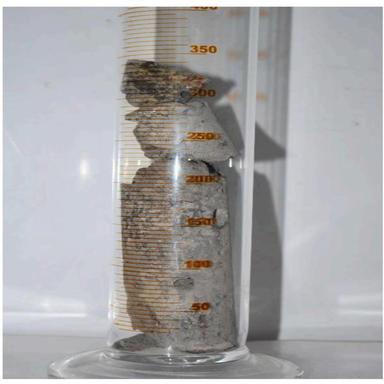
Sample retrieved from the stratified pool after core drilling.